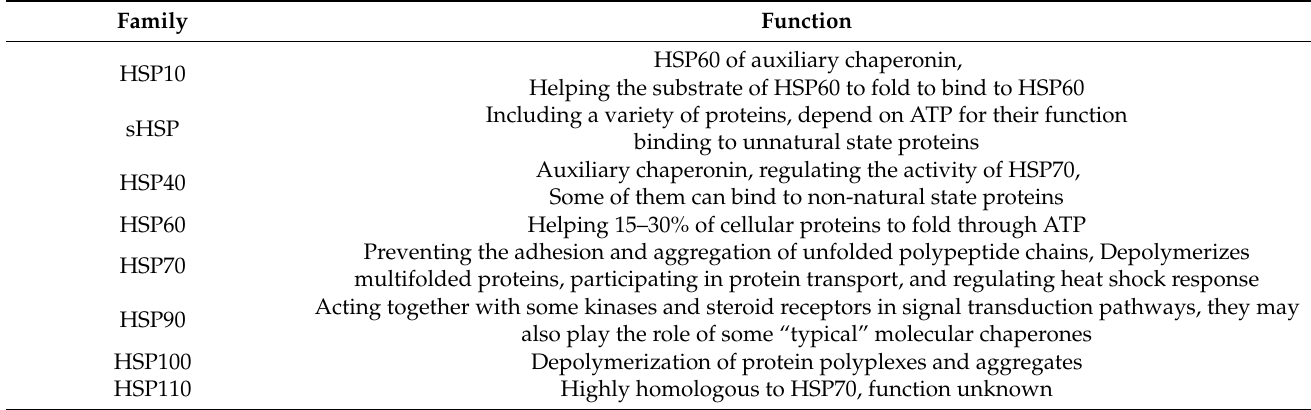
Table 9. Family of molecular